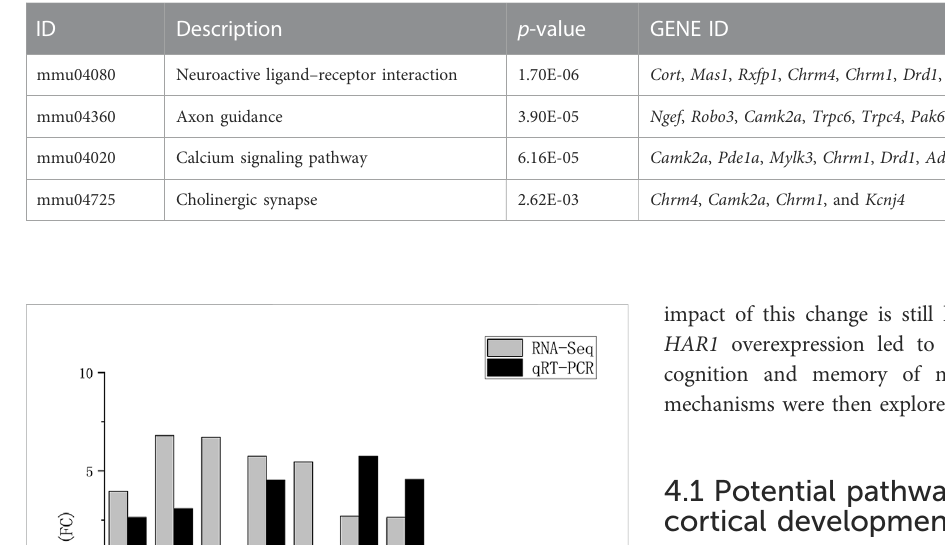
TABLE 3 Results of KEGG analysis related to brain development.